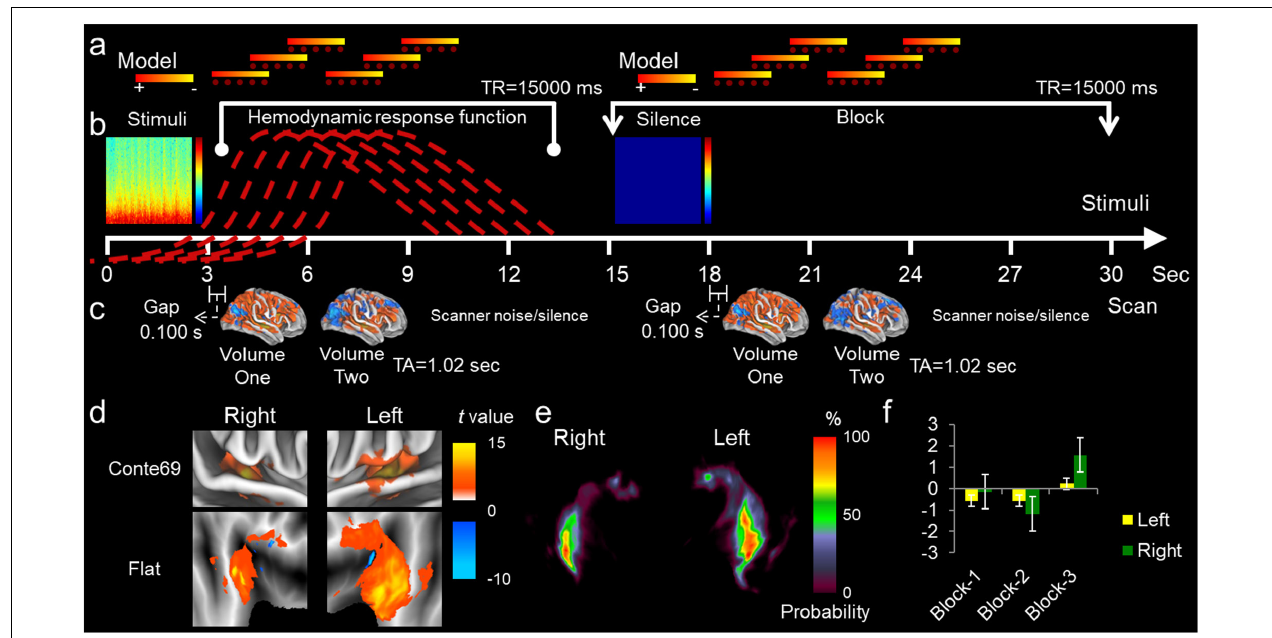
FIGURE 1 | Experimental design. (a) General linear model using double gamma function convolved to a canonical hemodynamic response function (b) . Where there is a sound stimulus presented, the model evaluates the relationship between our categories (i.e., EVs/regressors) and the dependent variable (BOLD signal). The stimuli are represented as a spectrogram with time on the x-axis and frequency on the y-axis. The color bar represents high frequency in red and low frequency in blue. Each red dashed line represents a putative hemodynamic response function. A model above the red dashed line is represented by a colorbar with high BOLD signal in red ( + ) and low BOLD signal in yellow ( − ). For a block of sound presentation, varying the model would tentatively capture the hemodynamic response function. For the presentation of a silent stimulus, seen to the right of the sound stimulus, varying the model should capture resting state or error associated with the model since no sound stimulus exists. (c) Below the time line, two volumes were acquired per block separated from the stimuli presentation by gap times from 0.1 to 2.0 s. The TA is 1.02 s and the TR = 15,000 ms. Each volume was acquired in 1.02 s and separated from the preceding volume by 1 s. The remaining time within a block was the silent period consisting of background scanner noise in the MRI room (i.e., the helium pump of the cryomagnetic; Hoiting, 2005). (d) From the two volume acquisitions, regions of interest were extracted pertaining to Heschl’s gyrus for the left and right hemisphere. The color bar represents activation from 0 to 15 t -value and deactivation from 0 to -10 t -value. The Heschl’s gyri were extracted based on probabilistic maps (e) , where the color bar represents the probability of finding Heschl’s gyrus within that location from 0 to 100%. From the activation/deactivation maps, average t -values were calculated (f) .